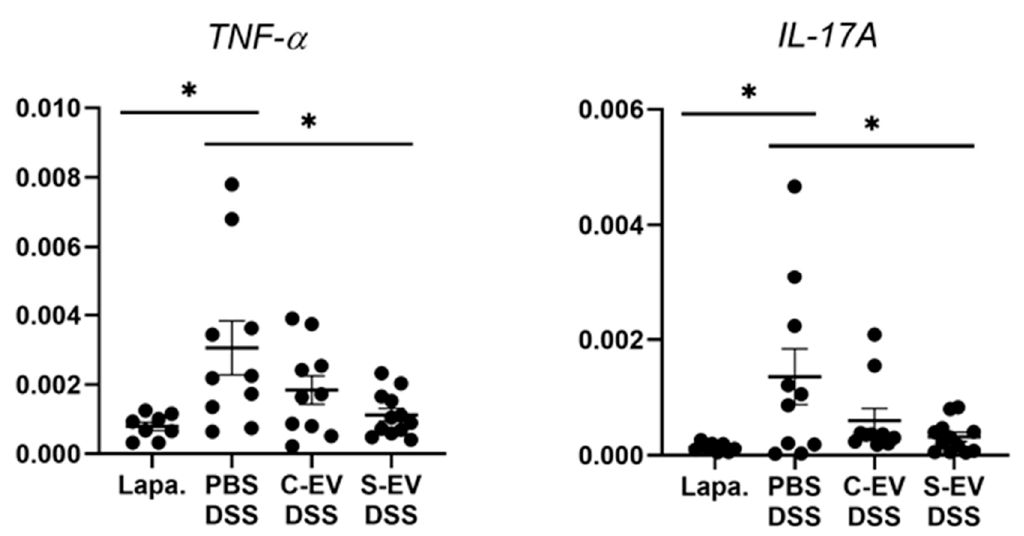
Figure 2. RT-qPCR analysis for gene expression of TNF- α and IL-17A. Gut inflammation was induced in the mice by 2.5% DSS-containing drinking water for seven days. Direct injection of either vehicle or di ff erential UC-isolated EVs into the lumen of the tied ileum was done on day 7 and the tissues were separated after 18 h for RNA extraction. Relative expression of genes to β -actin in ileal-loop tissues of mice was accessed. Lapa, laparotomy; PBS, phosphate-bu ff ered saline (200 µ L); C-EV, control EVs (50 µ g / 200 µ L) injected; S-EV, sepsis EVs (50 µ g / 200 µ L) injected into ileal space; and DSS, dextran sulfate sodium. Other abbreviations: TNF- α , tumor necrosis factor- α ; IL-17A, interleukin-17A. N = 8–12. * p < 0.05.